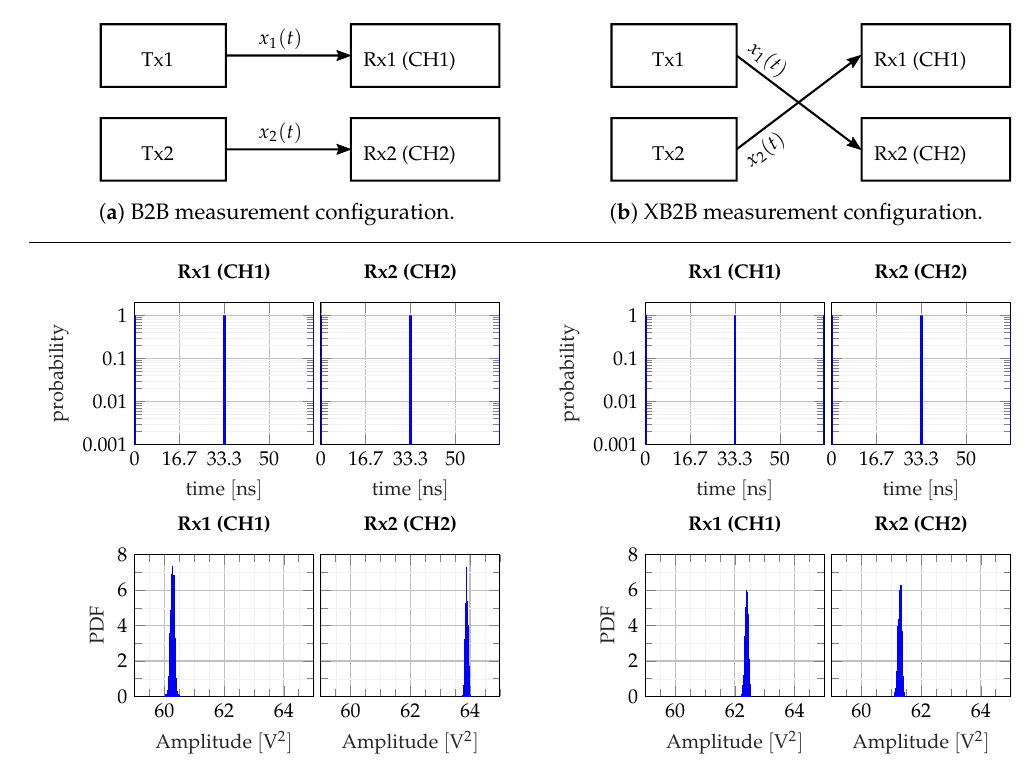
Figure 15. Synchronization stability test using iteratively synchronized data recording in back- to-back (B2B) and crosswise back-to-back (XB2B) configurations: 9th-order M-sequence driven at f 0 = 7.68GHz, 1000 iterations. The diagrams signify the indicated statistical properties of the corresponding pulse peak in terms of pulse peak position in time domain as well as the the distribution of pulse amplitude